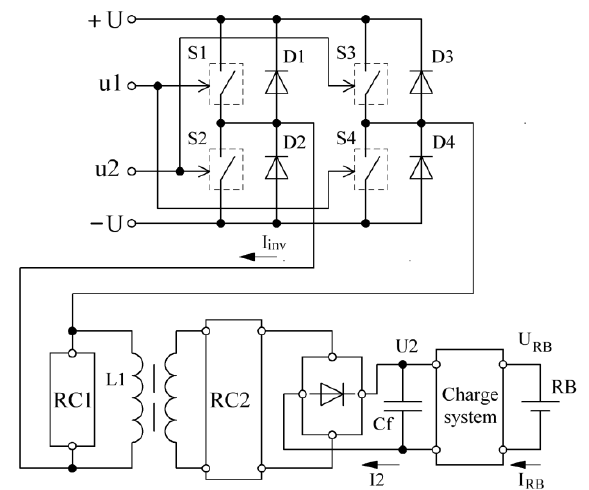
Figure 2. Block diagram of the contactless charge